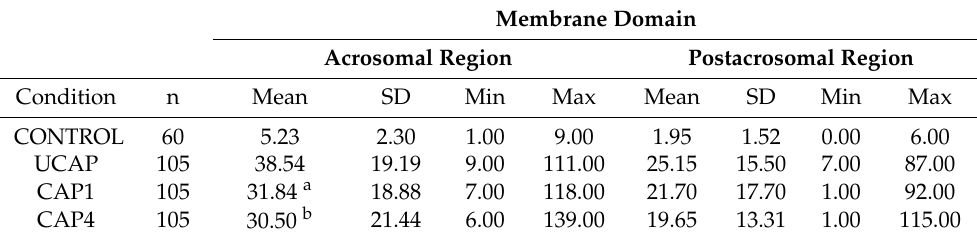
Table 1. Densities of terminal and linked fucose recognized by AAA lectin registered in both the acrosomal and postacrosomal